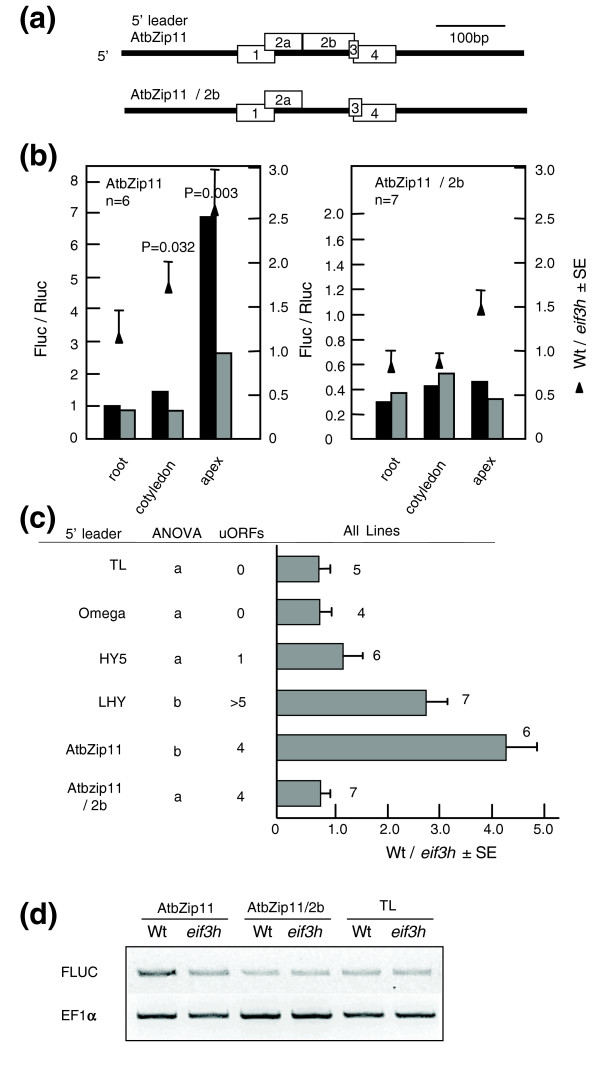
uORF2b contributes to poor translatability of the AtbZip11 leader in the eif3h mutant. (a) Schematic of the arrangement of uORFs in the AtbZip11 leader. uORF2b was mutated by changing its start codon into a stop codon. (b) Translation efficiencies of the AtbZip11 leader lacking uORF2b in three different organs of two-week-old seedlings. The number of lines examined is indicated (n), as are p values derived from pairwise t-tests. For details see legend to Figure 1. (c) Summary of transgenic reporter gene translation assays on six different leader sequences. The number of transgenic lines examined is indicated for each leader, as is the number of uORFs per leader. The letters a and b indicate homogeneous subsets as determined by ANOVA/Tukey test. Thus, leaders that do not share the same letter (a, b) differ significantly in their dependence on the eIF3h protein. SE, standard error. (d) Reverse-transcriptase PCR analysis of FLUC mRNA levels in representative transgenic lines harboring TL-FLUC, AtbZip11-FLUC or AtbZip11/2b-FLUC transgenes. The EF1α mRNA was analyzed as a control for equal mRNA levels. The ethidium-bromide stained gels shown here are consistent with other repeat experiments performed with other subsaturating numbers of PCR cycles.